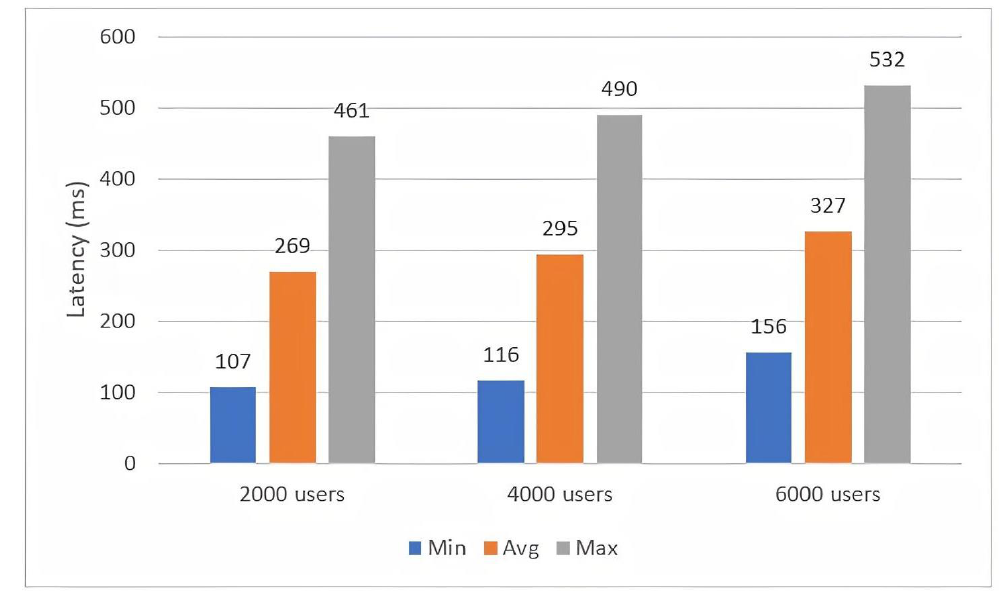
Figure 7. Performance assessment for invoked